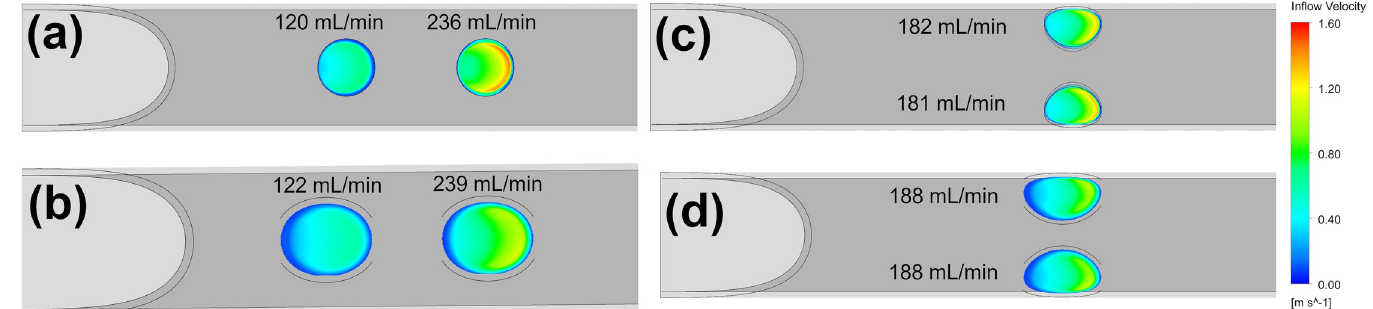
Fig 11. Velocity contours and flow rates for the Linear circular (a), Linear oval (b), Parallel circular (c) and Parallel oval (d).